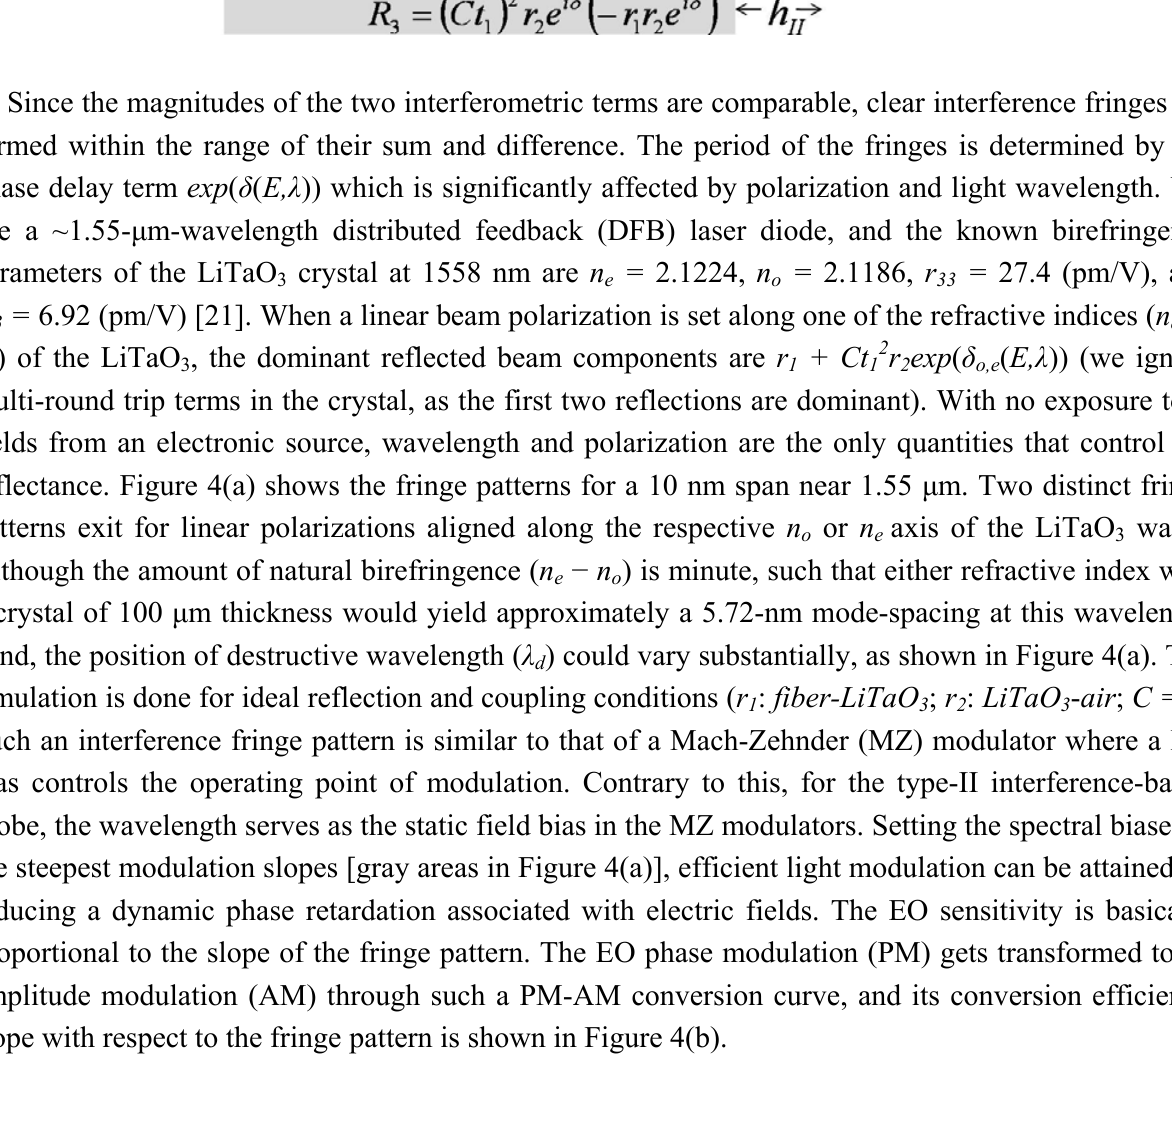
Figure 3. Reflected field components for type II probe scheme (identical condition to Figure 2, except no HR coating. Here, R